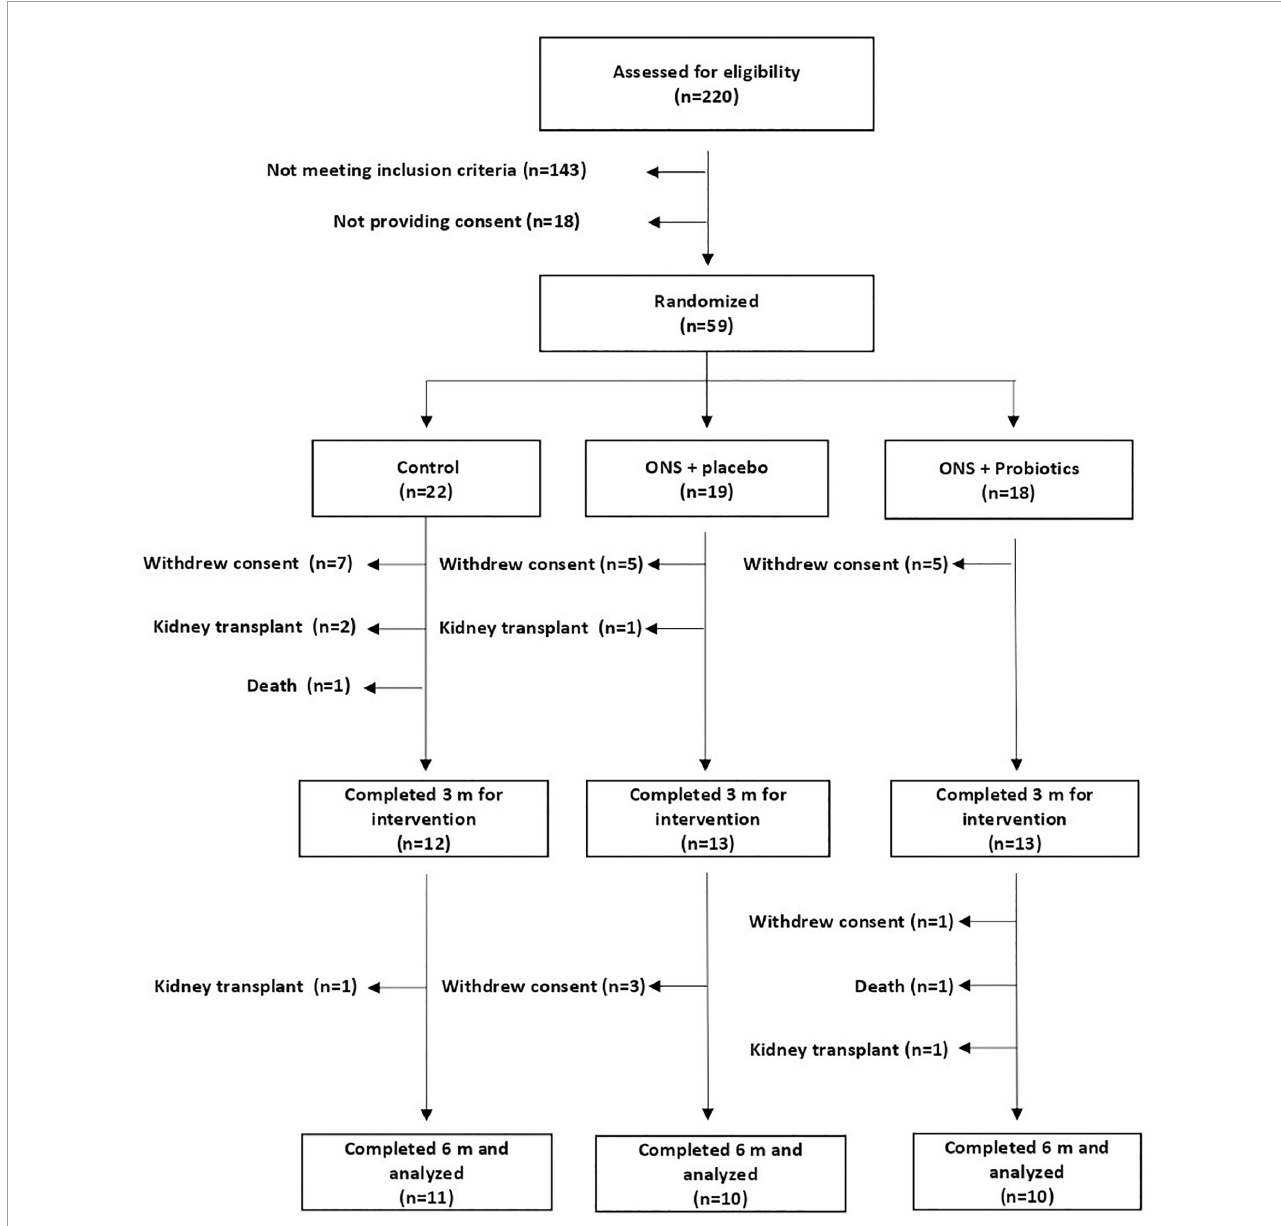
FIGURE1 Study flowchart. ONS, oral nutritional